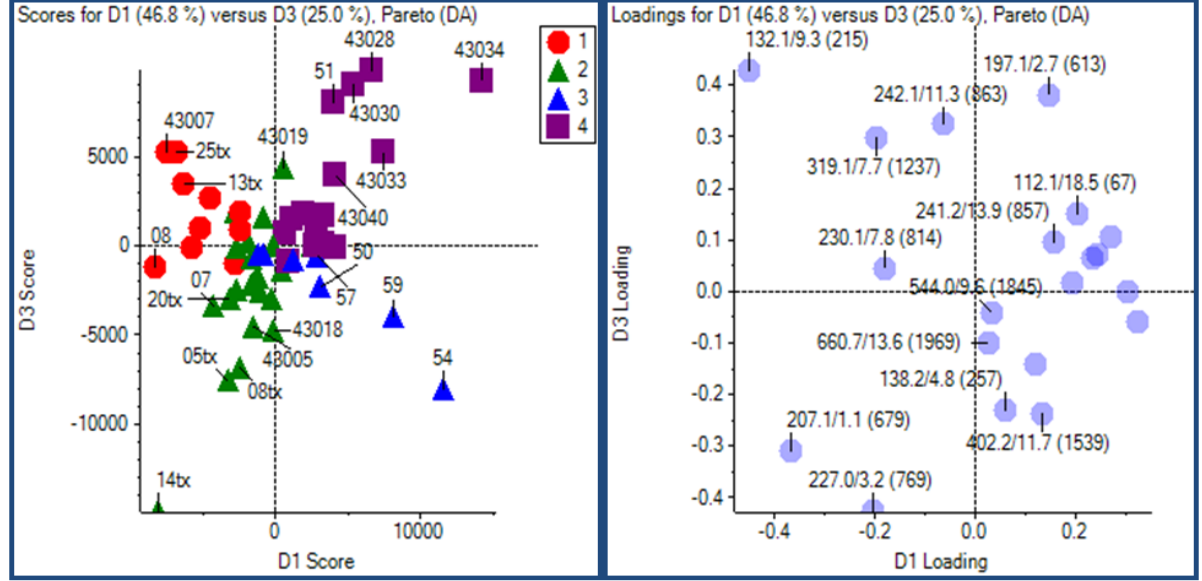
Figure 8. PCA-DA plots of the ccRCC HILIC-LC–ESI–MS after genetic algorithms (GA) feature selection.